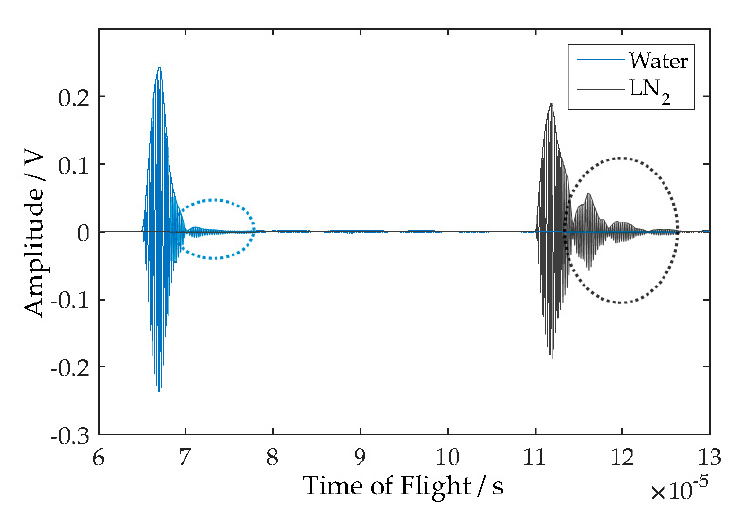
Figure 3. Received acoustic signals from a single transmission path measurement in water at 293 K (blue curve) and LN 2 at 77 K (black curve).